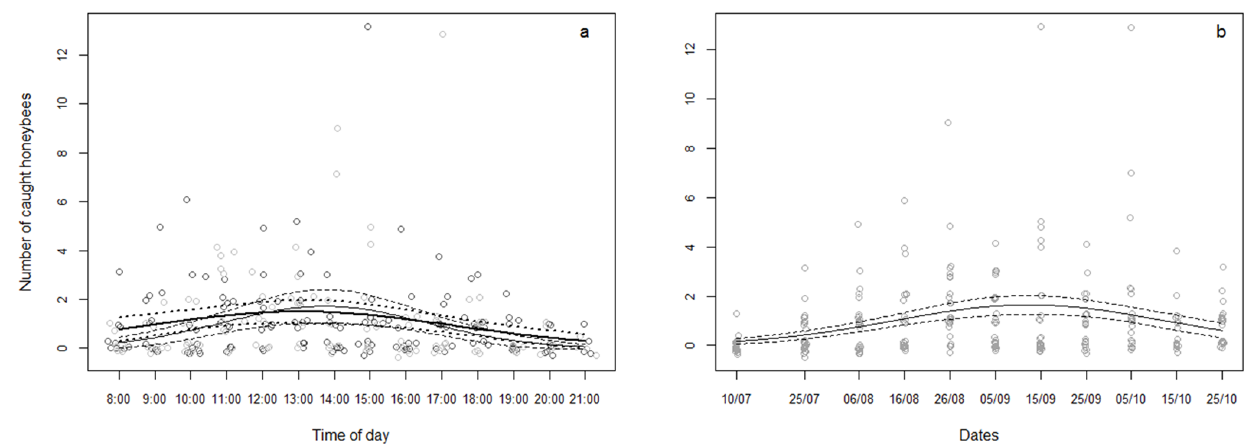
Figure 6. Number of honeybees caught by Vespavelutina during a) the day and b) the season. For (a), H1 data are in bold line/dark grey dots and H2 data are in thin line/light grey dots. For (b), the data are pooled for H1 and H2. Predicted values fitted with the GLM model (plain line) with 95% confidence interval (dash lines).